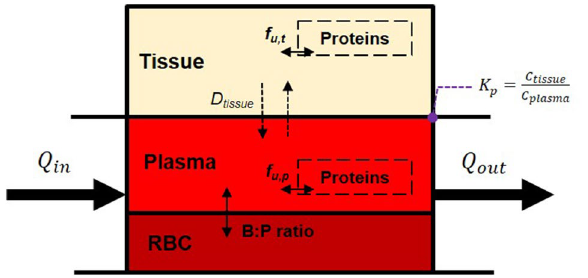
Figure 1. Basic diagram of quasi-2D tissue distribution in a compartmental model. D tissue is the diffusion coefficient for a compound across the plasma-tissue barrier; fu refers to unbound drug concentration in plasma (p) and tissue (t), and Q refers to blood flow rates through a tissue